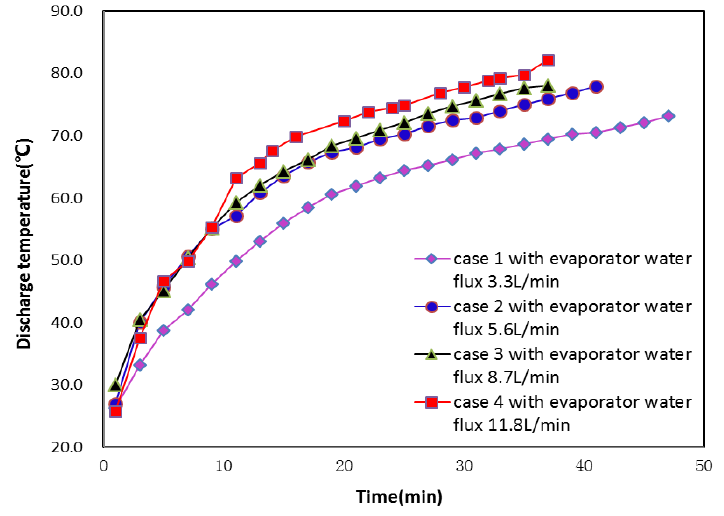
Figure 10. Compressor discharge temperatures at different evaporator water fluxes.